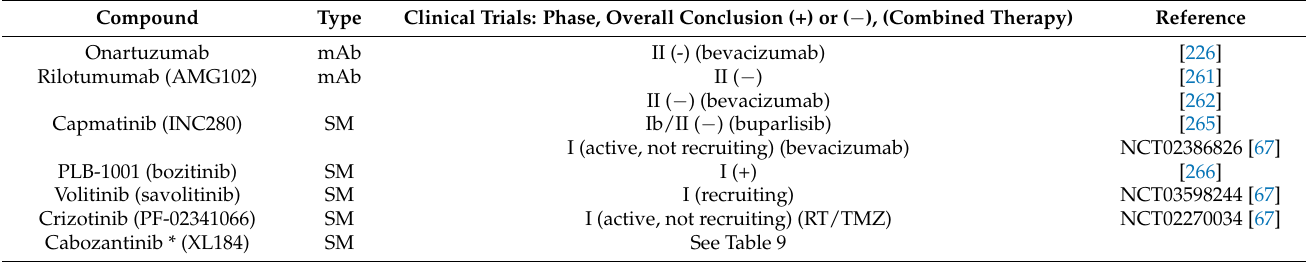
Table 5. Clinical trials in GB targeting MET (hepatocyte growth factor receptor). Compound Type